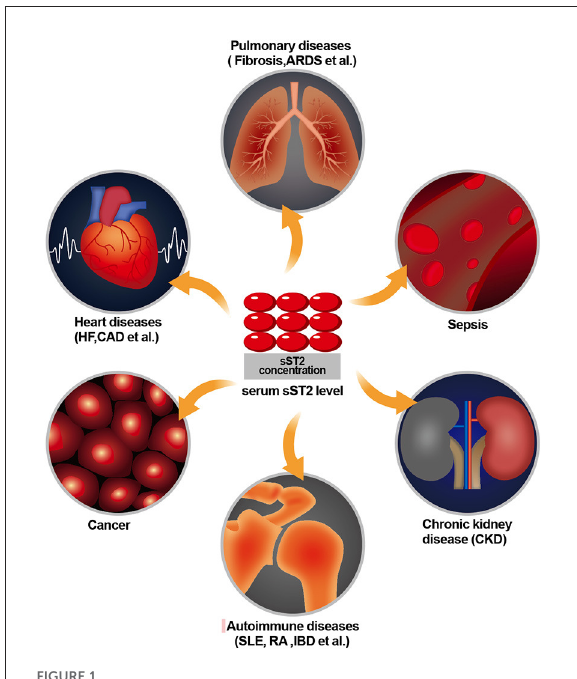
FIGURE1 Role of sST2 in diseases of various